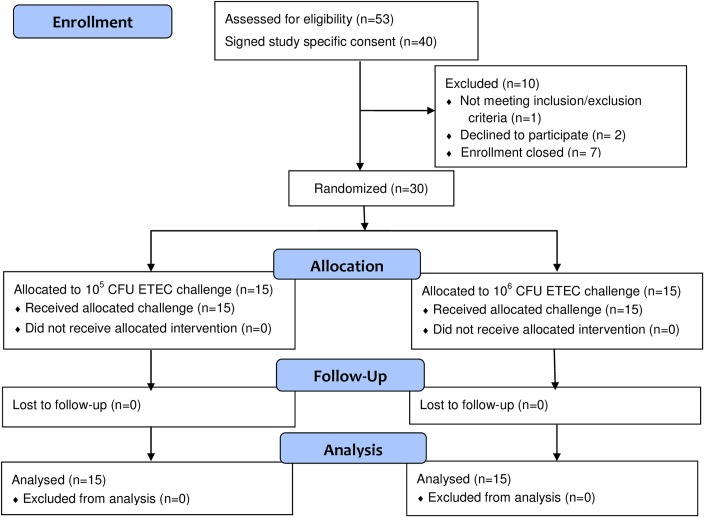
Flow chart of subject enrollment and retention in the study.